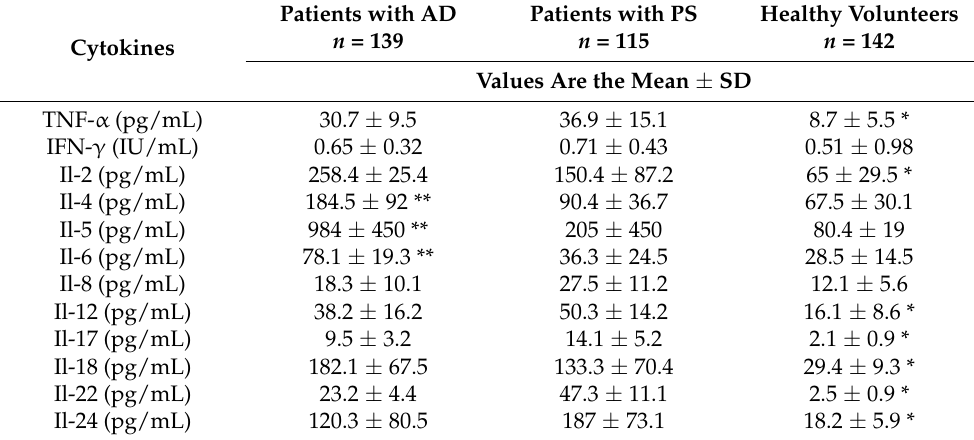
Table 3. The cytokine profiles of the blood serum of the studied patients and controls. Patients with AD n = 139 Cytokines